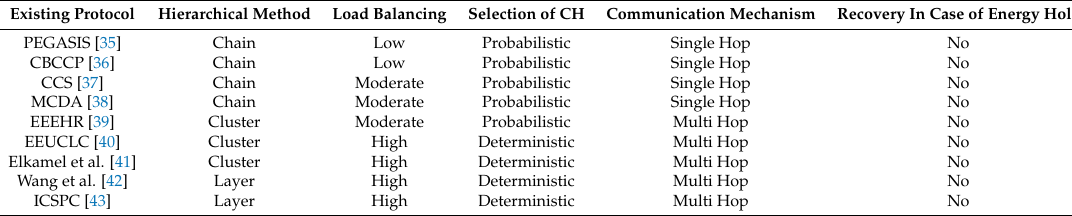
Table 1. Comparison of existing protocols mitigating energy hole